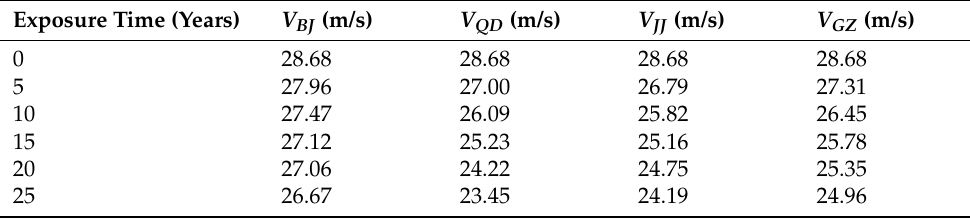
Table 9. Collapsed basic wind speed statistics at different exposure times in each region.